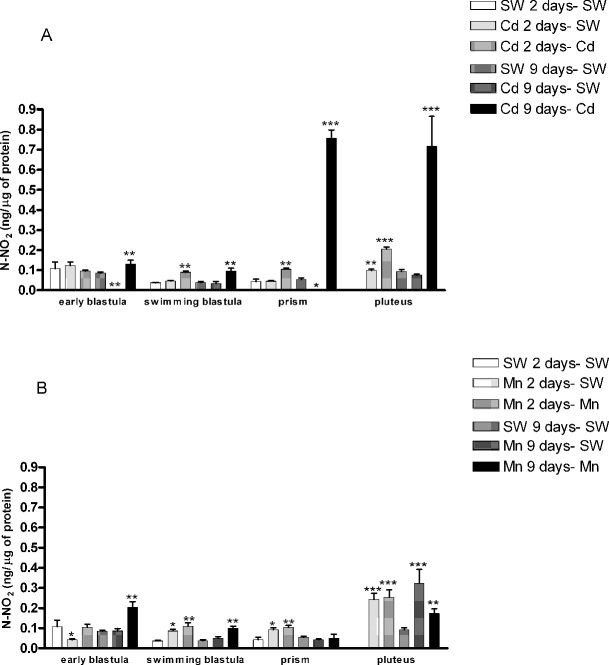
Total NO concentration in the progeny of P. lividus females exposed to cadmium and manganese.Different developmental stages of the offspring of females treated with cadmium (Cd) 10−6 M (A) or manganese (Mn) 3.6 x 10−5 M (B) for 2 and 9 days and reared in sea water (SW) or in SW containing metals were examined for nitrite content, as reported in Material and Methods. Significant differences compared to the respective control (SW 2 and 9 days) *P<0.5, **P<0.01, ***P<0.001. Two-way ANOVA, Bonferroni’s post test (P<0.05). N = 6.